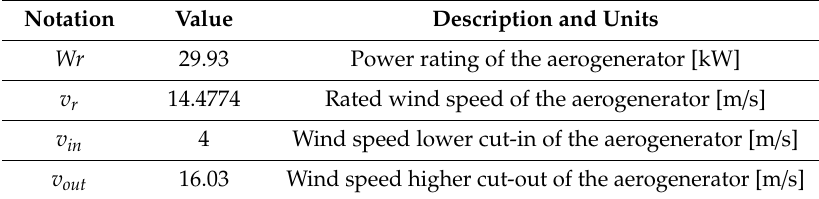
Table 5. Wind power system parameters (for F 4 ( x ) calculation).